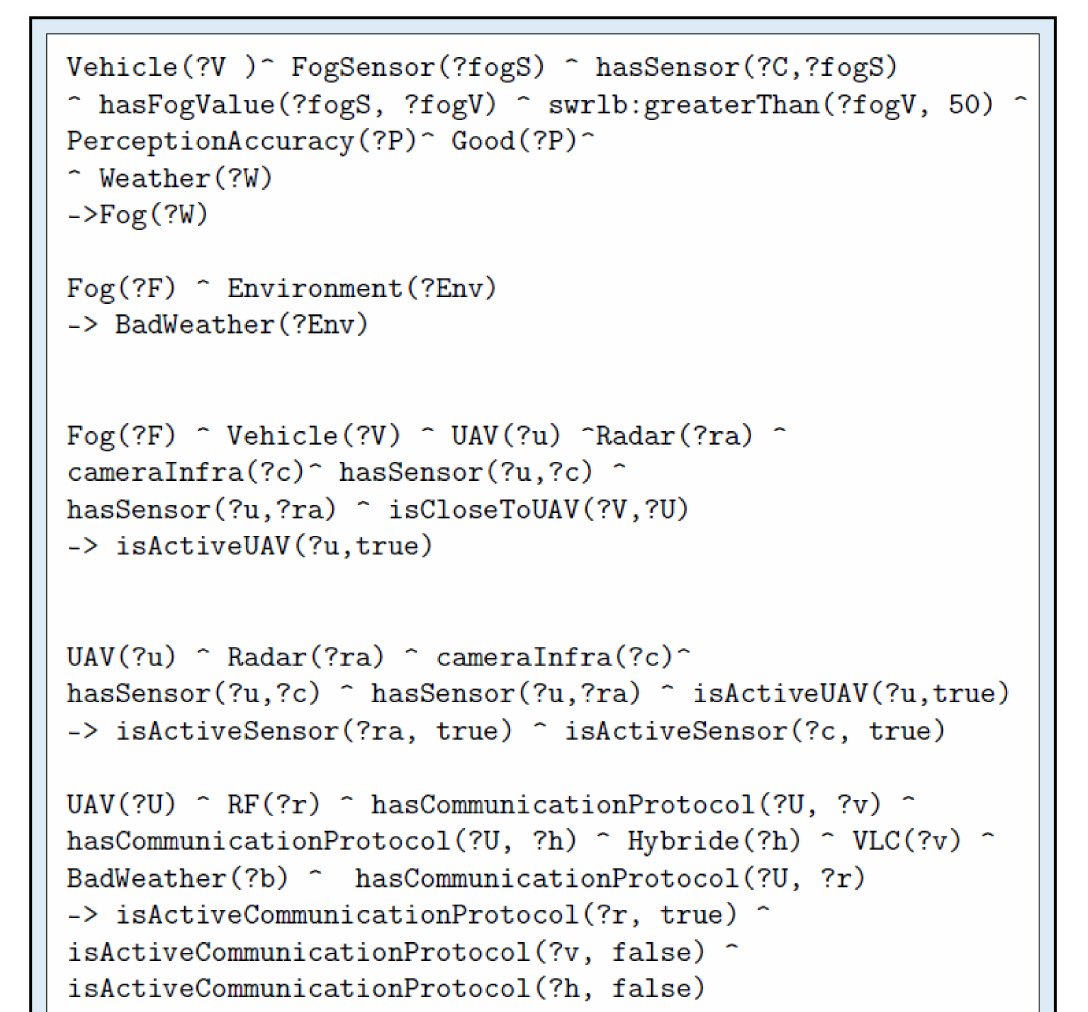
Figure 30. Set of rules for the foggy area part of the use case